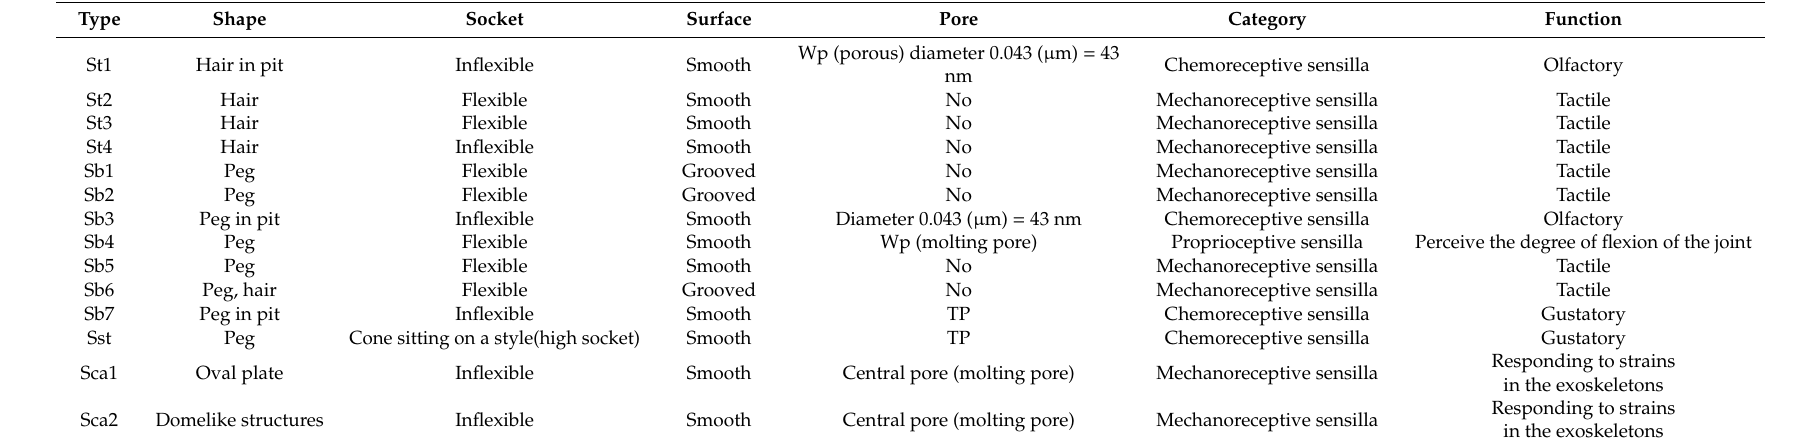
Table 3. Terminology and definition of sensilla used in this paper including terms from previous studies [27,54,55], Wp, wall pore; Tp, tip